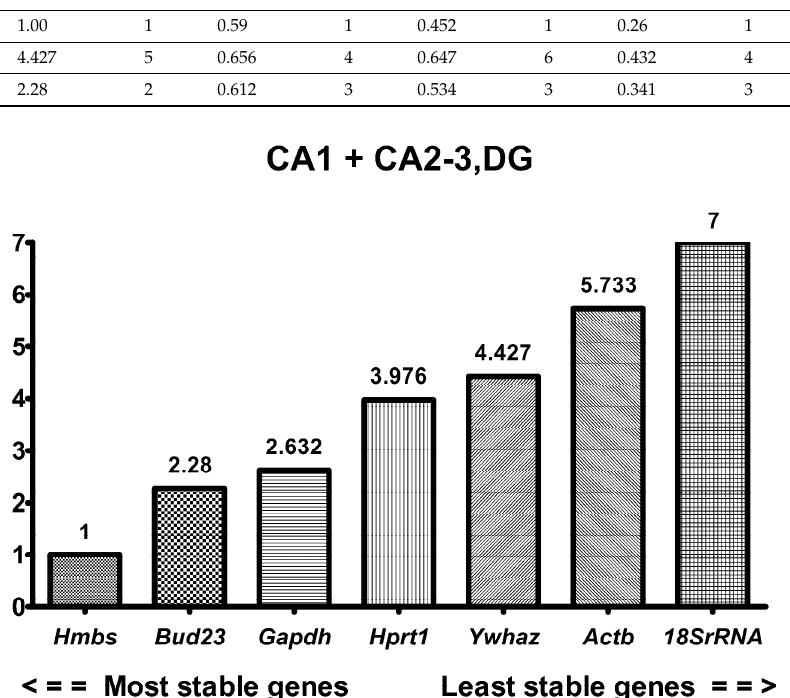
Figure 5. RefFinder stability rankings of 7 candidate reference genes in CA1 + CA2-3,DG parts of gerbil hippocampus, calculated collectively. Data are presented from the most stable (left) to the least stable gene. n = 30.